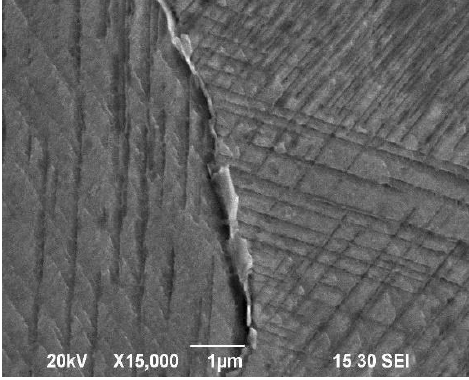
Figure 9. Deformation twins at the austenite grain boundaries.